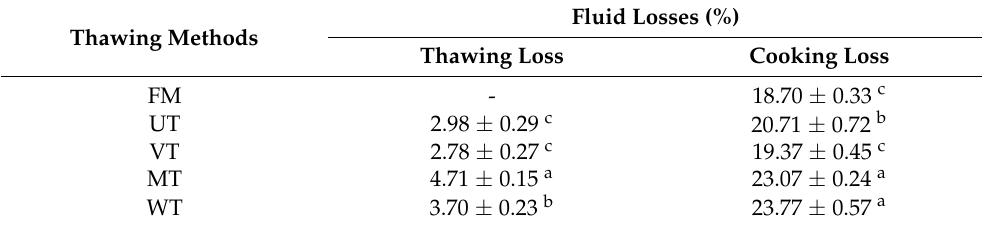
Table 1. Change in fluid losses of porcine longissimus dorsi induced by thawing methods. Thawing Methods